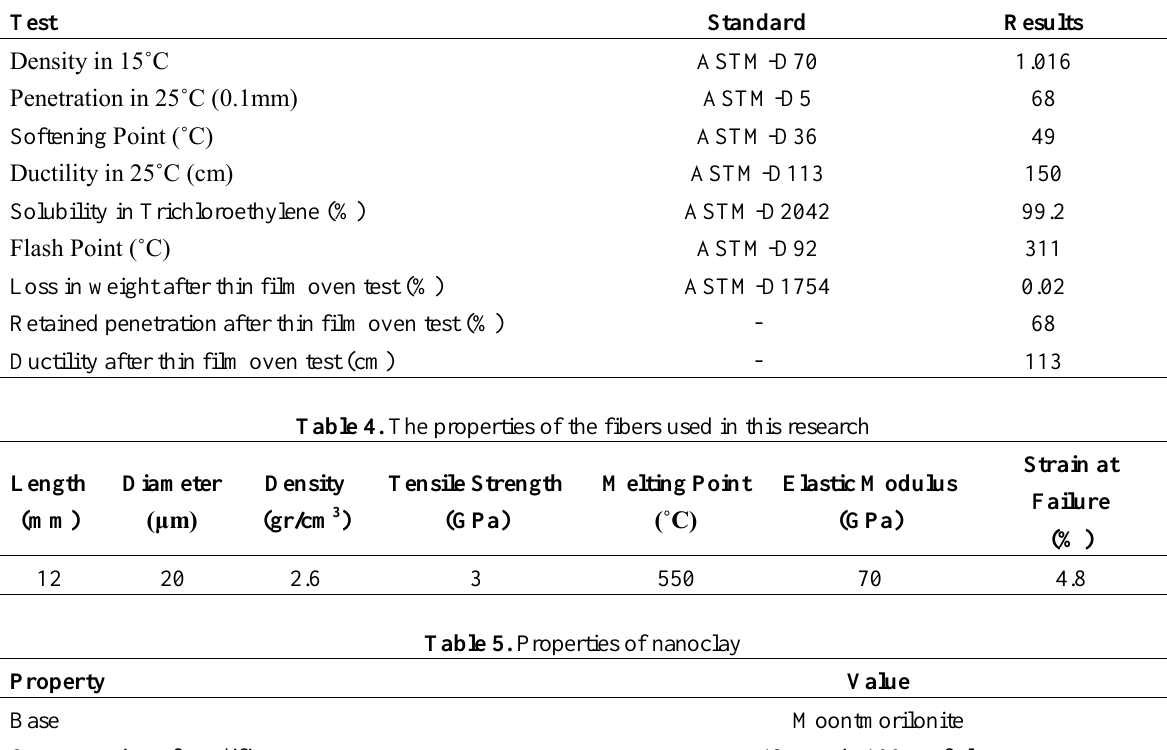
Table 3. Specifications of the bitumen used in this research